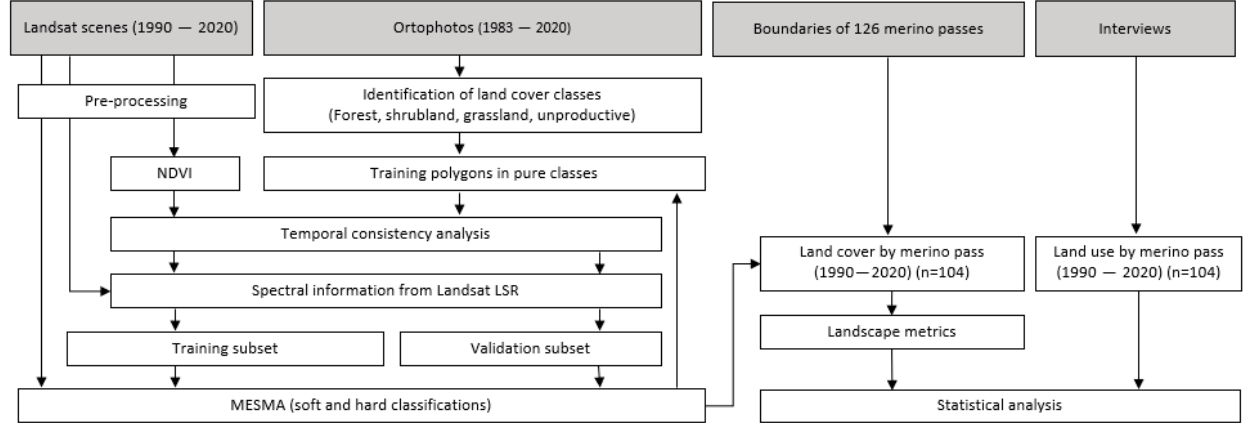
Figure 2. Materials used in this study (shaded in grey) and methodology fl owchart (shaded in grey and green). NDVI—Normalized Di ff erence Vegetation Index; MESMA—Multiple Endmember Spectral Mixture Analysis.